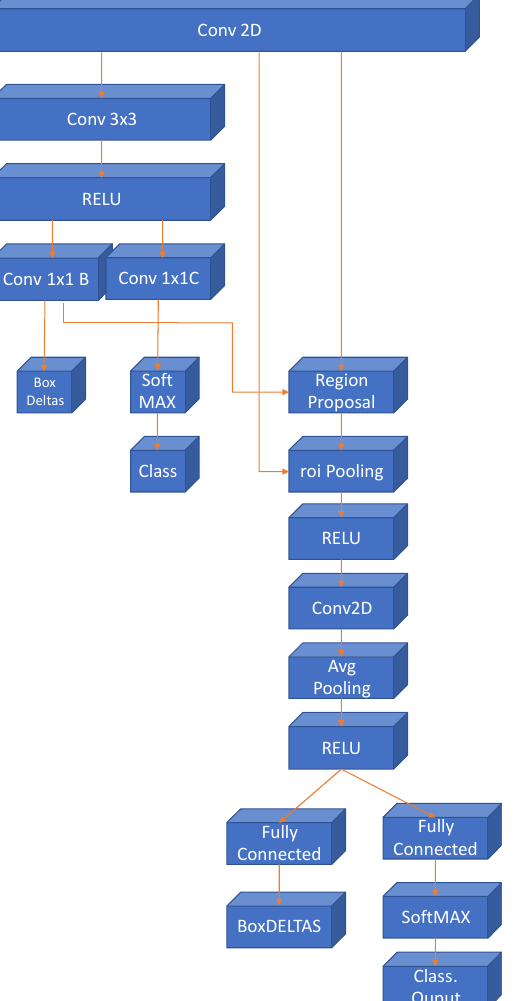
Figure 7. Final layers of the gesture detector using the proposed CNN in this work in a Faster RCNN architecture.